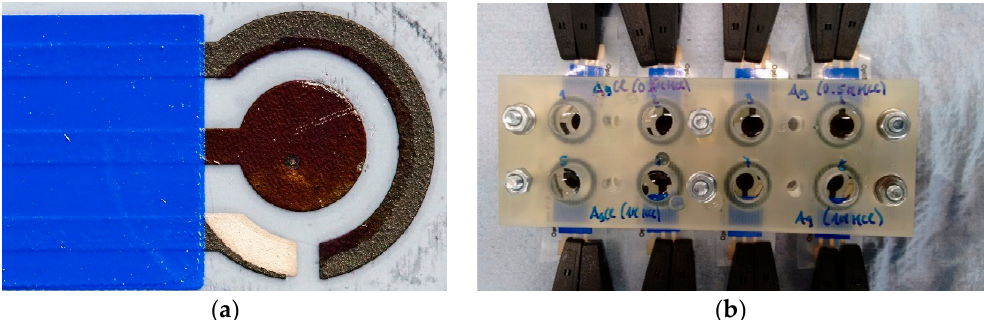
Figure 1. ( a ) A three-electrode sensor structure manufactured with screen printing of silver (contact pads, connections and reference electrode) and carbon (working and auxiliary electrode); ( b ) set-up of the parallel pH calibration measurements in a 3D printed measurement